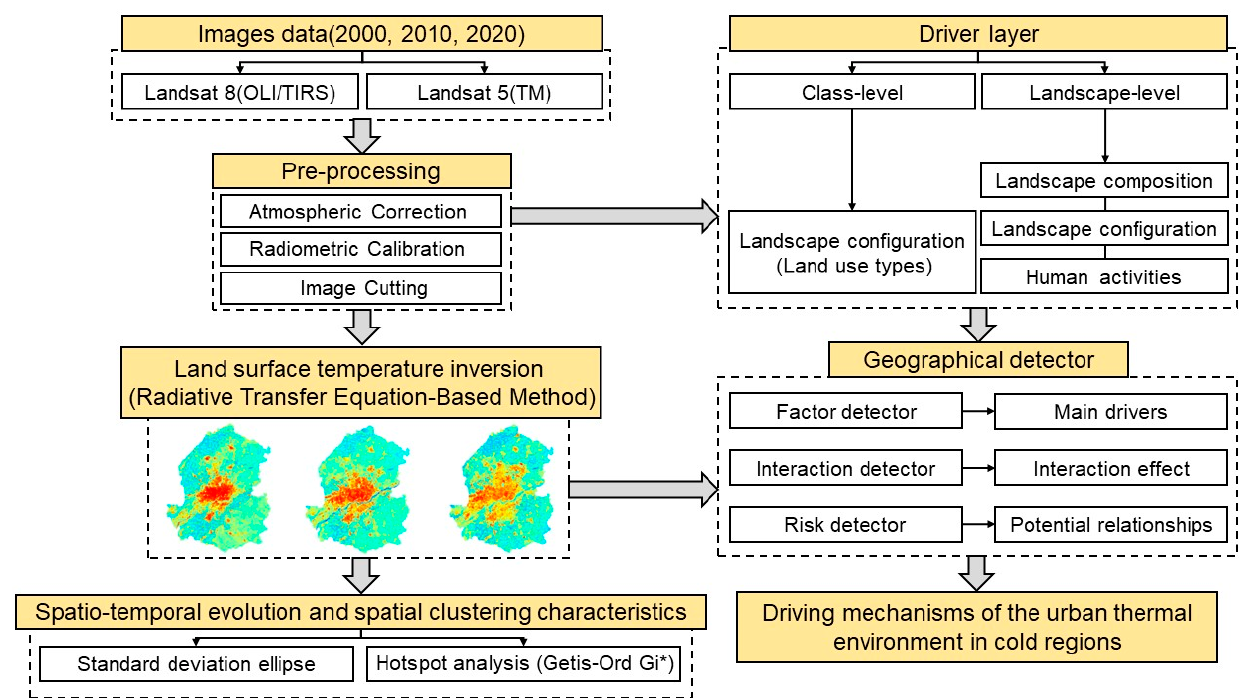
Figure 2. Flow chart.